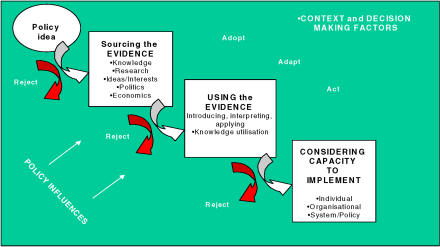
The Evidence-Informed Policy and Practice Pathway